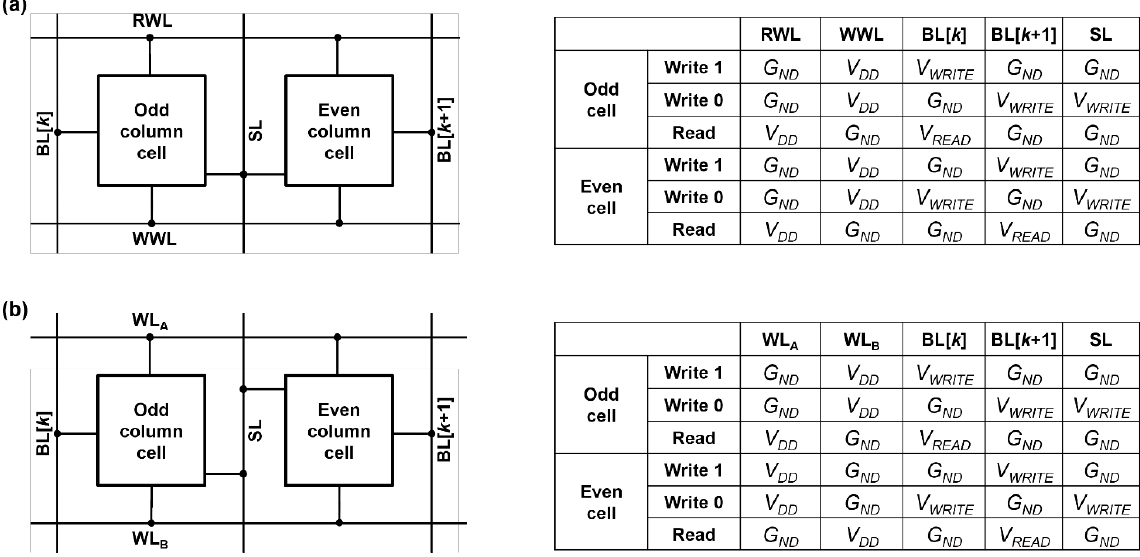
Table 1. Parameters of storage devices.